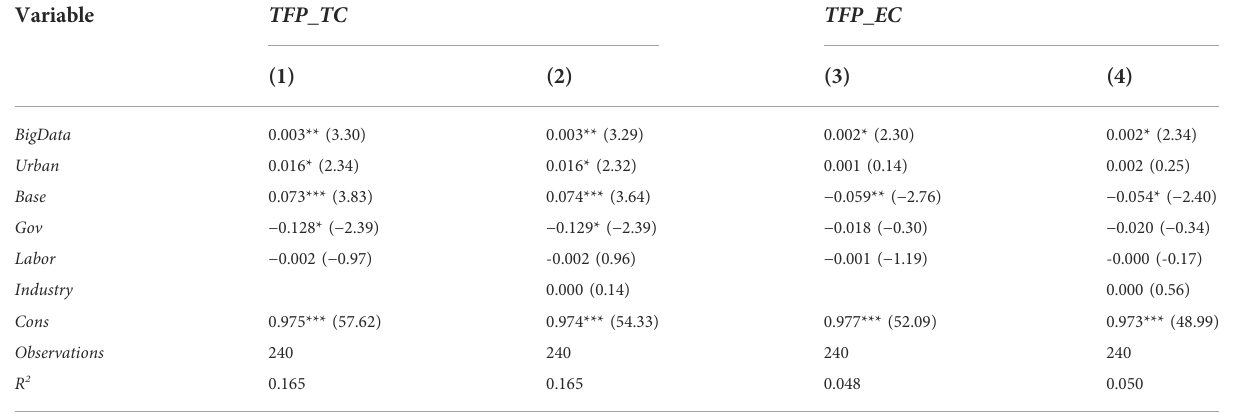
TABLE 3 Analysis of mechanisms affecting green economic